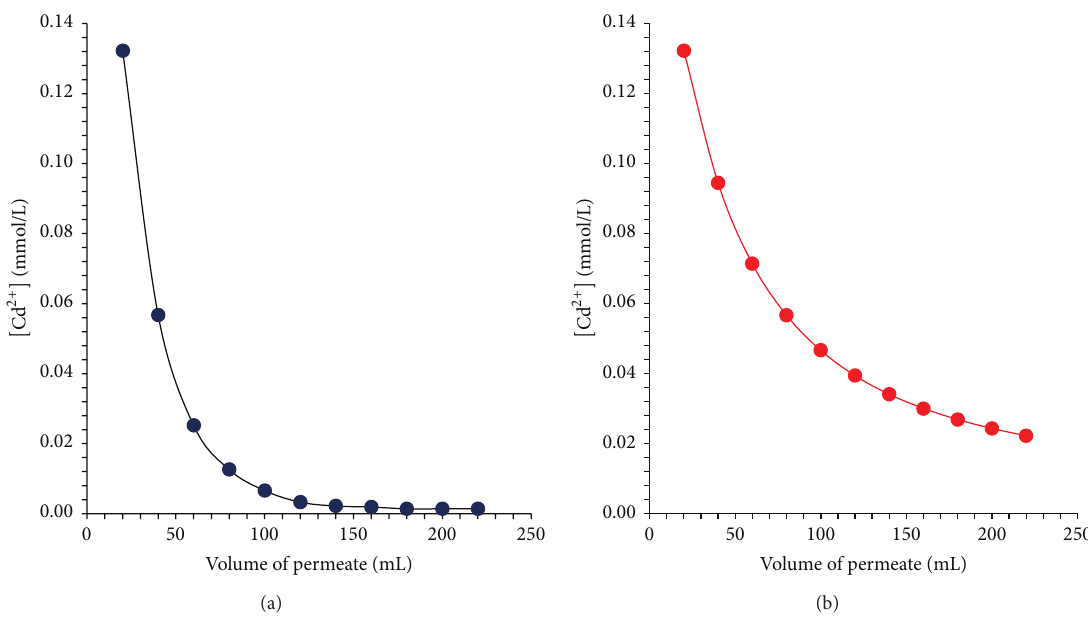
Figure2:AverageCd 2+ concentrationvaluesofpermeatefractionscollectedinthetubes(a)andeffectiveconcentrationvaluesinthepermeate according to (6) (b).